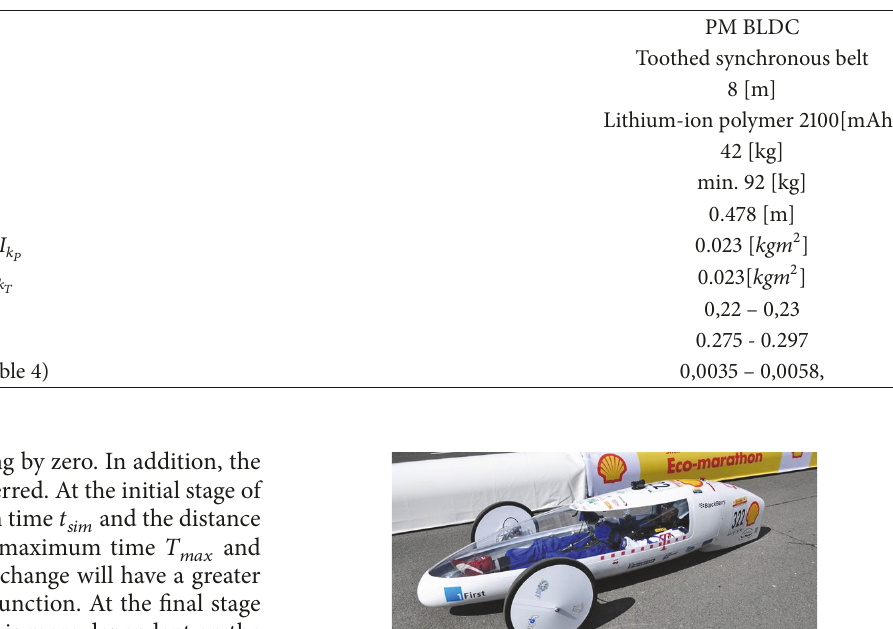
Table 1: Research object main parameters.